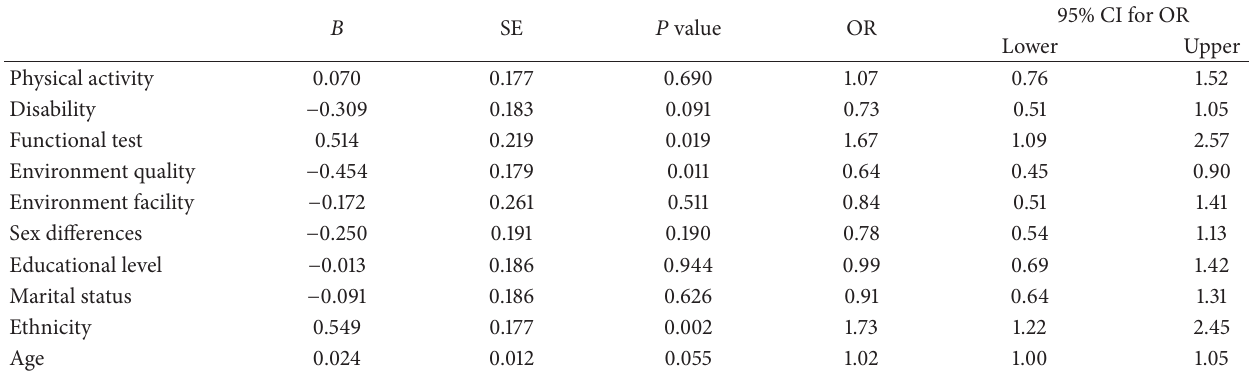
Table 3: Prevalence of falls and associations derived by logistic regression